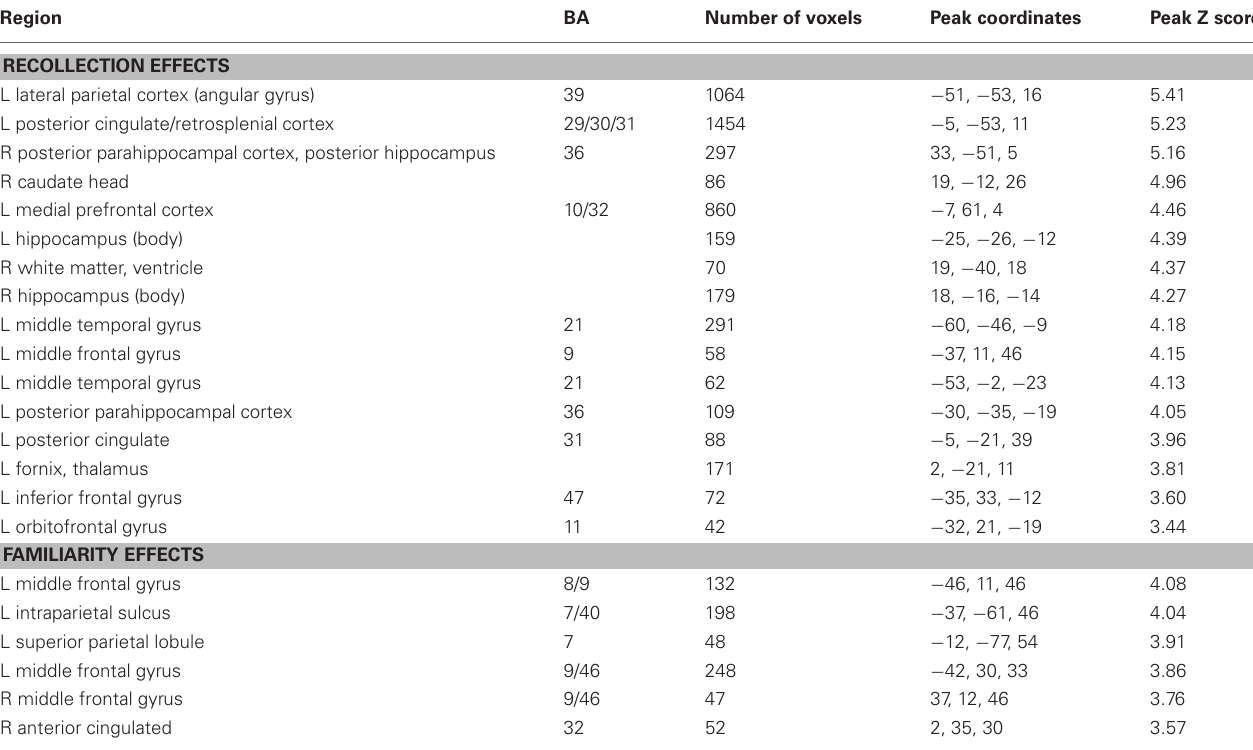
Table 2 | Regions exhibiting effects exclusively related to recollection or familiarity. Region